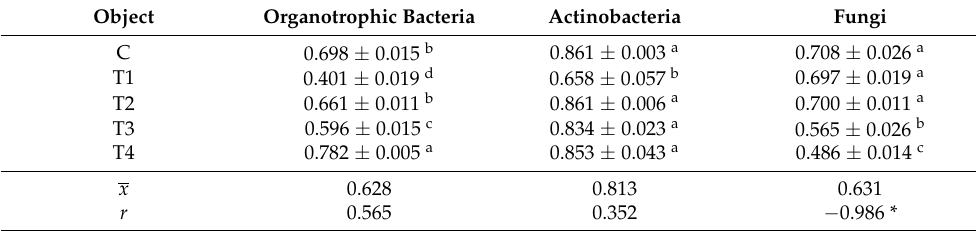
Table 2. Effect of tebuconazole on the ecophysiological diversity of soil microorganisms measured using the EP